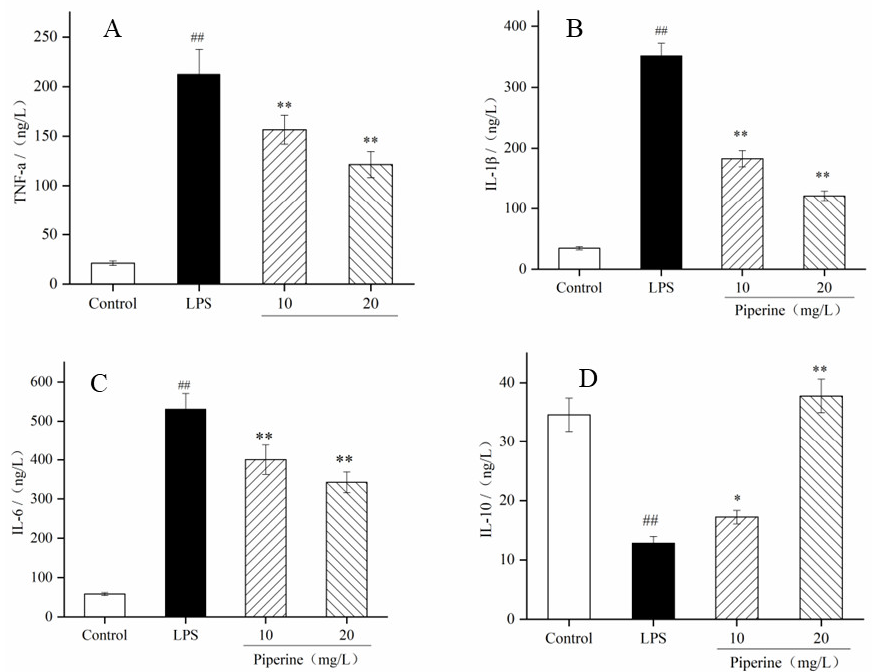
Figure 4. Piperine-inhibited LPS-stimulated TNF-α ( A ), IL-1β ( B ), IL-6 ( C ) and IL-10 ( D ) formation in RAW264.7 cells. Ave ± SD, ## p < 0.01 vs. control group; * p < 0.05 and ** p < 0.01 vs. LPS